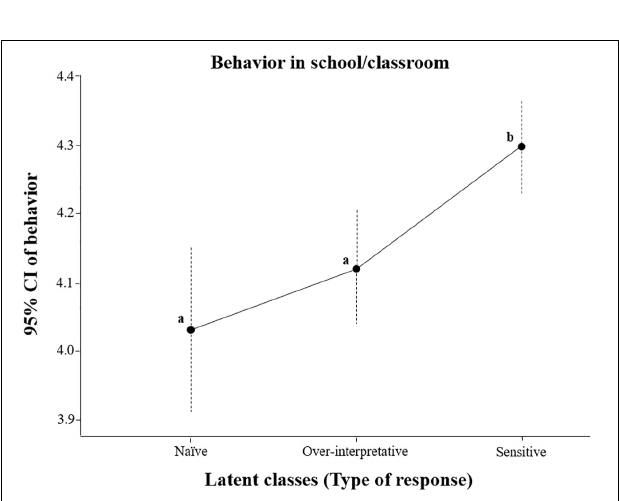
FIGURE 2 | Distribution of latent classes regarding behavior in school/classroom. Different letters (a,b) indicate significant differences in sensitive